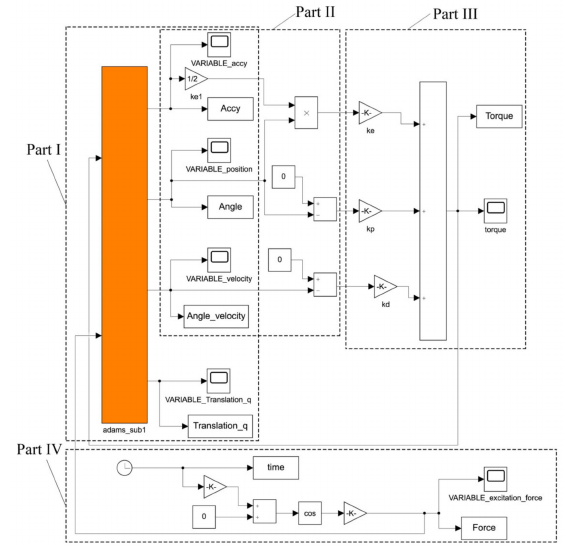
Figure 10. Saturation control model in